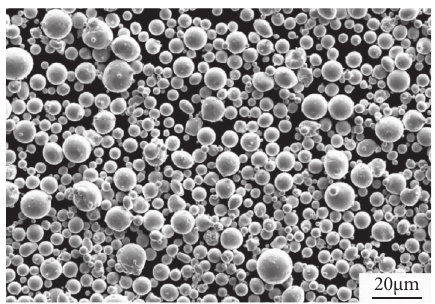
Figure 1: Microstructure of SLM 316L stainless steel